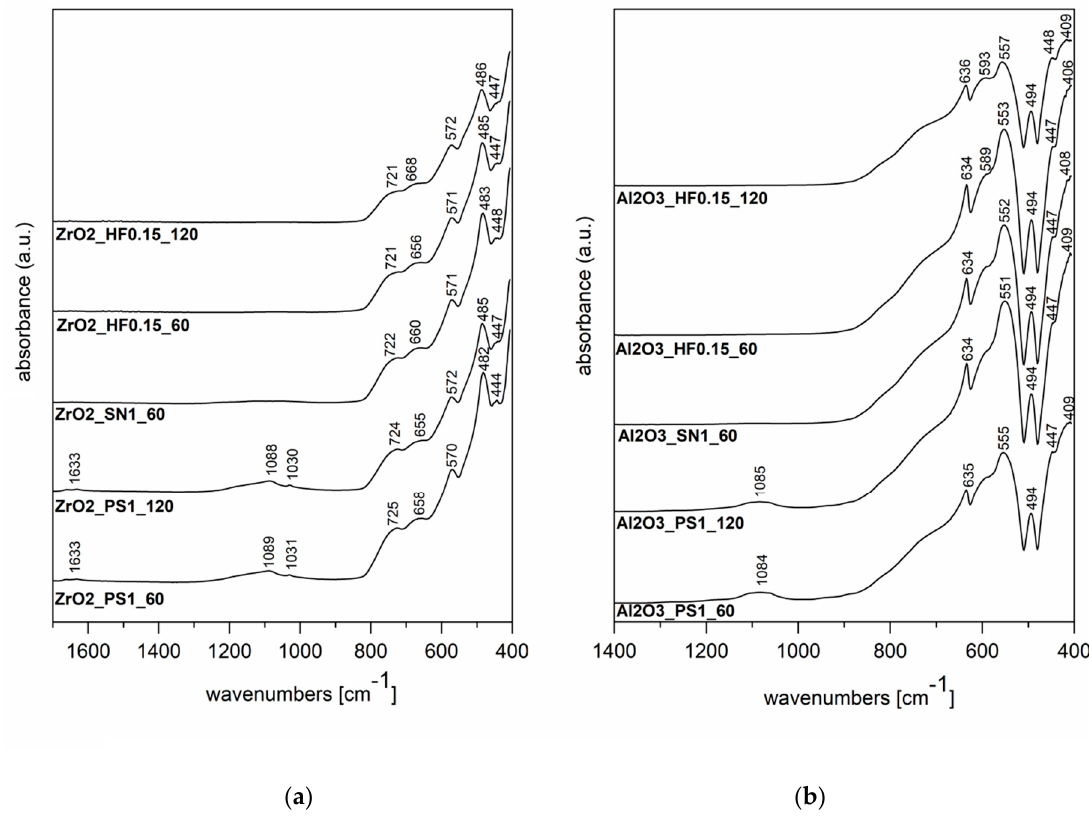
Figure 6. FTIR spectra of modified samples with denoted most intensive bands ( a ) samples of zirconia ceramics, ( b ) samples of alumina ceramics.